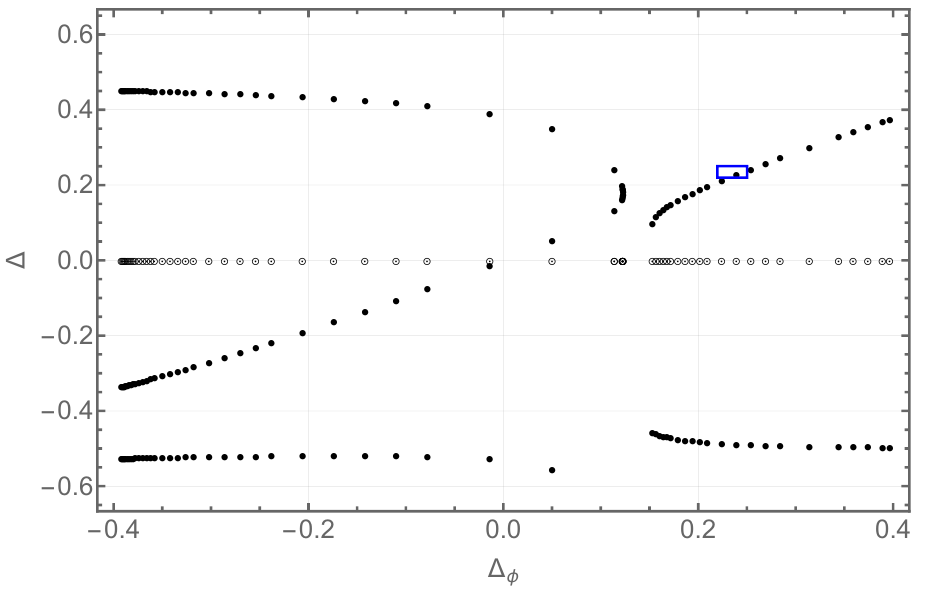
Figure 10 . Spin 0 roots of the extremal functional in 3 dimensions evaluated at increasing values of ∆ φ . The small blue box region is the expected scaling dimension obtained using the (cid:15) -expansion. Single roots are denoted by filled circles and double roots are denoted by dotted circles.